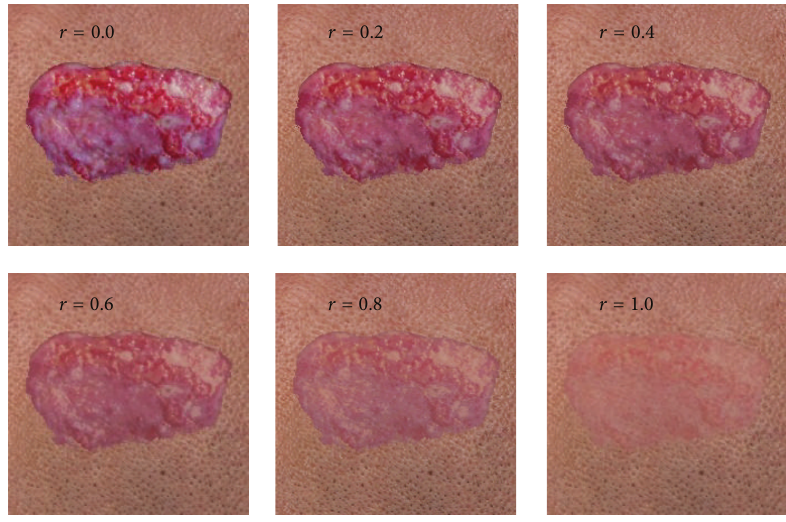
Figure 6: Color transformation of a wound with increasing recovery rate.